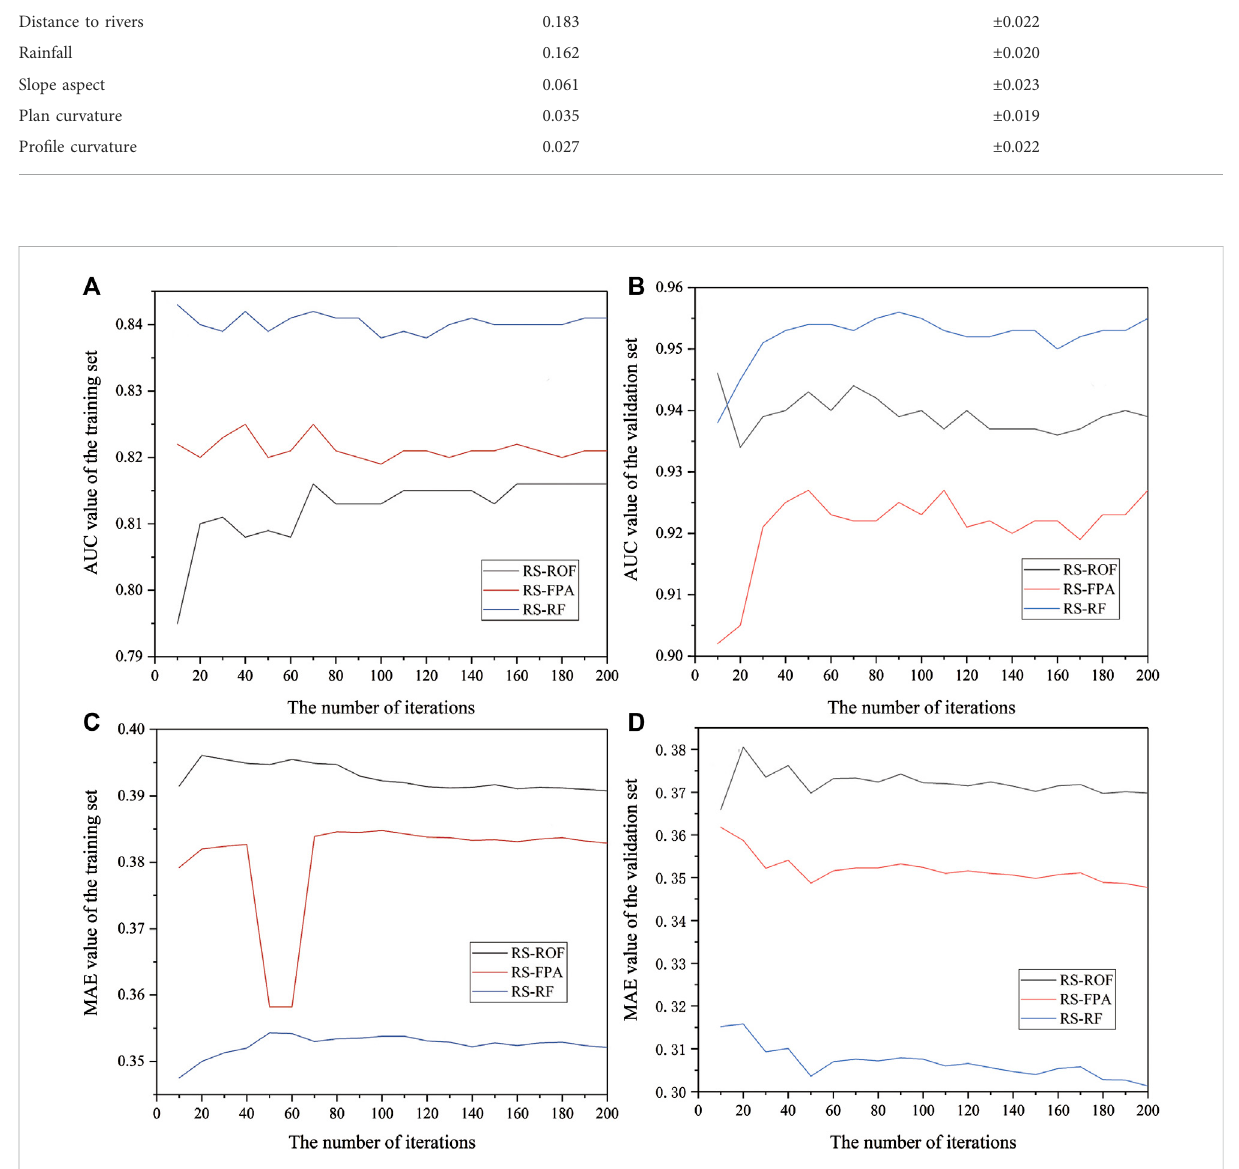
FIGURE 4 AUC and MAE of training set and validation set under different iteration times; (A) AUC value of the training set; (B) AUC value of the validation set; (C) MAE value of the training set; (D) MAE value of the validation